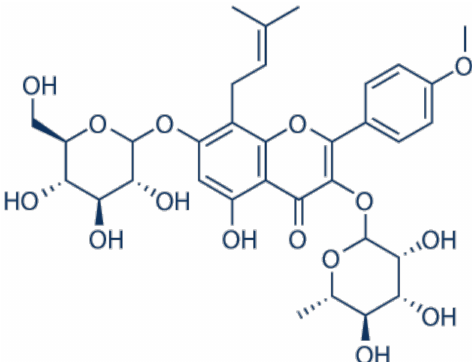
Figure 20. The chemical structure of